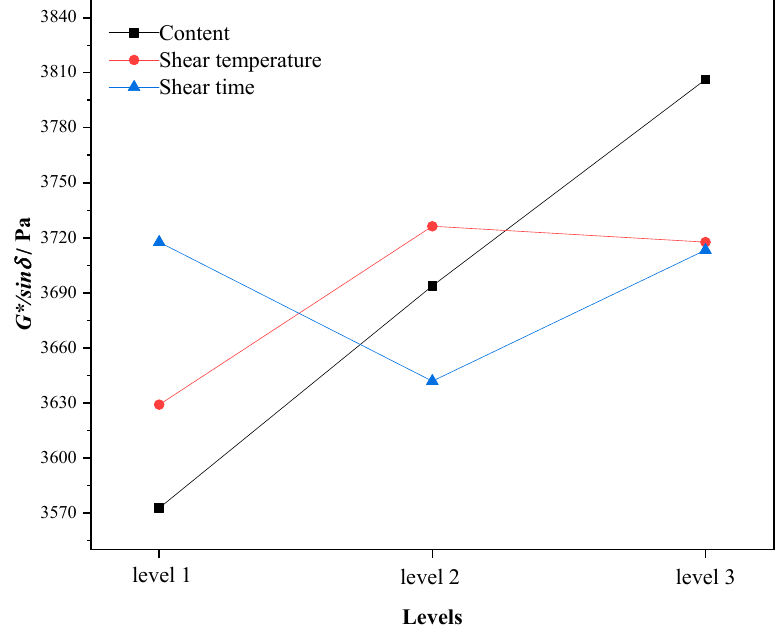
Figure 3. The variation of the mean 60 °C rutting resistance factor with the levels.